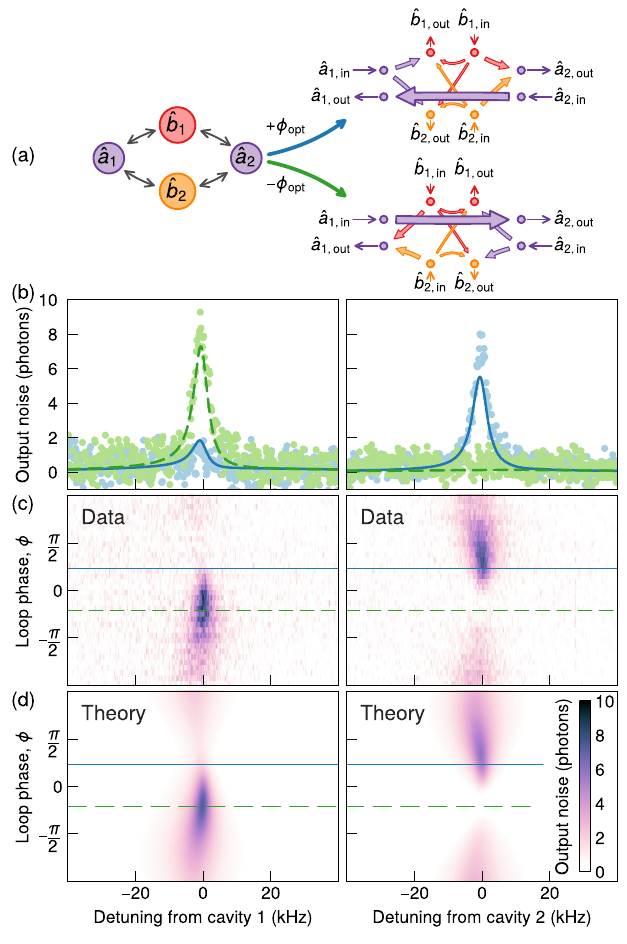
FIG. 4. Noise performance of the optomechanical isolator. (a) Graphical representation of signal flow. The mode-connection diagram (left) induces signal flow diagrams (right) at the optimal loop phases (cid:3) ϕ . Arrow widths are proportional to their opt corresponding scattering matrix element [Eq. (1)]. (b) Measured output noise at cavities 1 (left) and 2 (right) near loop phases þ 0 . 21 π (solid blue line) and − 0 . 21 π (dashed green line). We subtract constant noise offsets of 31.5 and 22.8 photons due to the measurement chain at the two cavity frequencies. (c) Output noise data (color scale) as a function of detuning from the cavity frequencies and loop phase. Lines indicate the cuts shown in (a). (d) Fit of the data in (c) to a coupled-mode theory with the mechanical environment occupation numbers as free